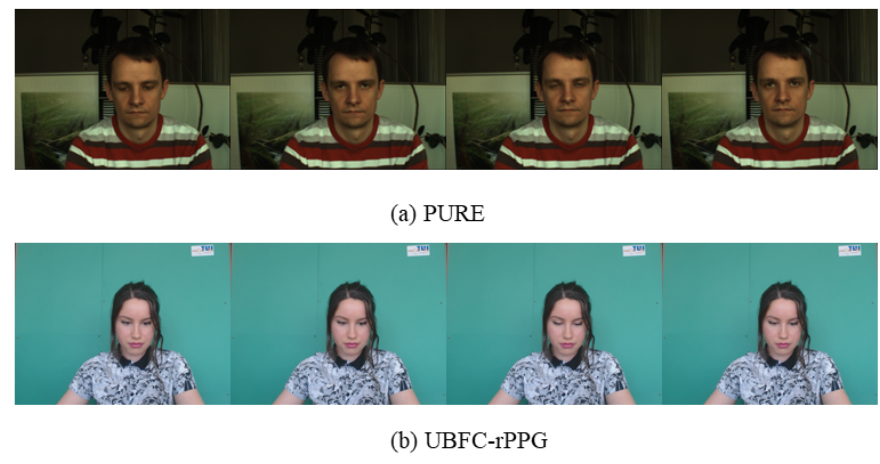
Figure 7. Examples of PURE and UBFC